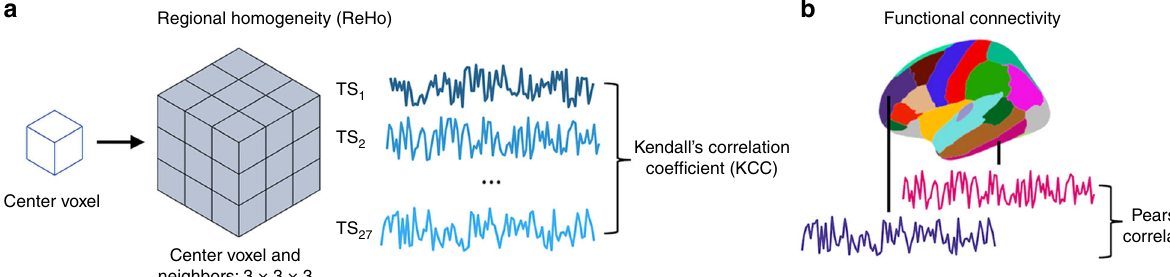
Fig. 1 Local and distant functional connectivity can be measured using different, related approaches. a Regional homogeneity (ReHo) measures the nonparametric concordance of adjacent voxel timeseries (TS). For each voxel in the gray matter (center voxel in the fi gure), a Kendall ’ s correlation coef fi cient value is computed between that voxel ’ s TS and its 26 neighbors who share at least a face, edge or corner with the center voxel. ReHo is a measure of local connectivity. b Conventional functional connectivity measures statistical dependency, often Pearson correlation, between the time-varying fMRI BOLD signal in two voxels or regions. In this example, mean timeseries from two distant regions in a parcellation are correlated to estimate functional